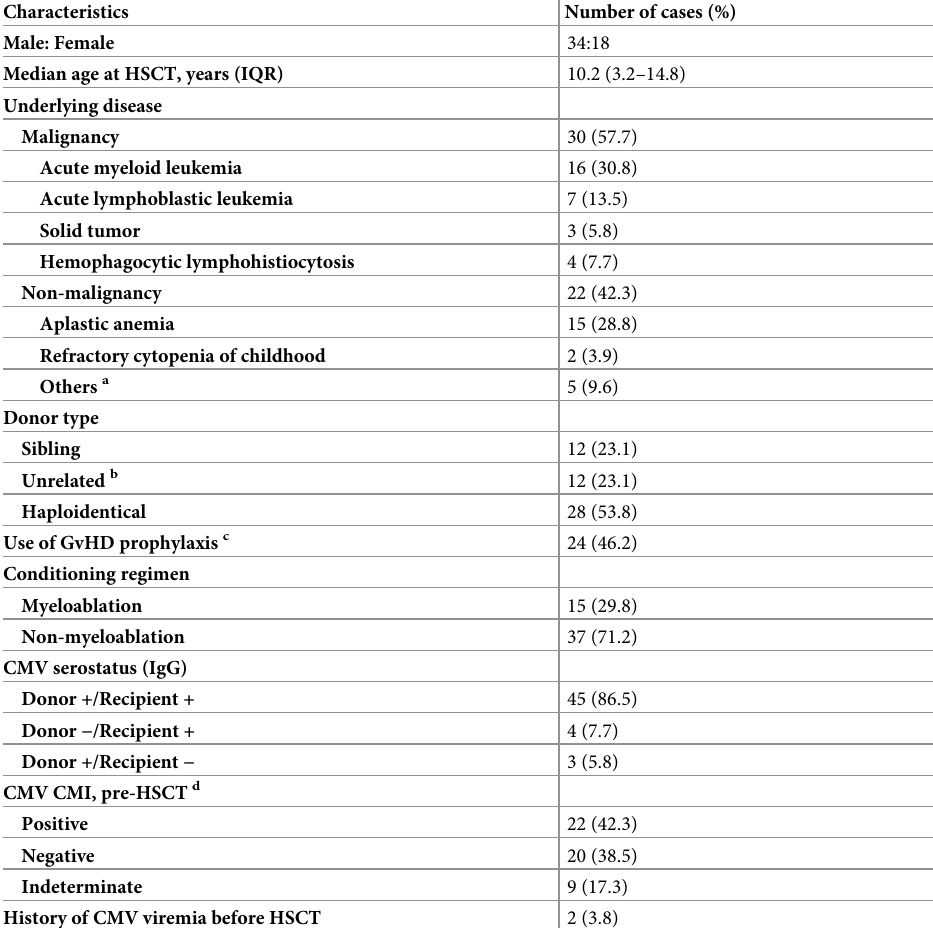
Table 1. Demographic and clinical characteristics of total 52 allogeneic HSCT